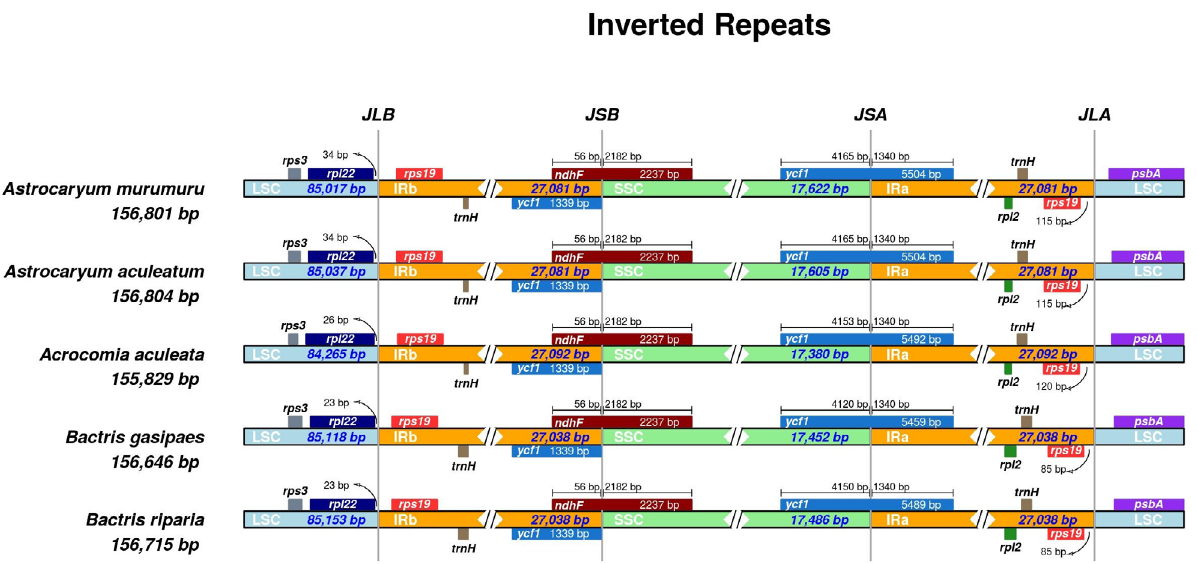
Figure 1 – Plot of Bactridinae plastomes comparing the IR junctions sites. Genes transcribed clockwise and counterclockwise are shown above and below of their corresponding tracks, respectively. JLB - IRb/LSC junction; JSB – IRb/SSC junction; JSA - SSC/IRa junction; and JLA - IRa/LSC junction.